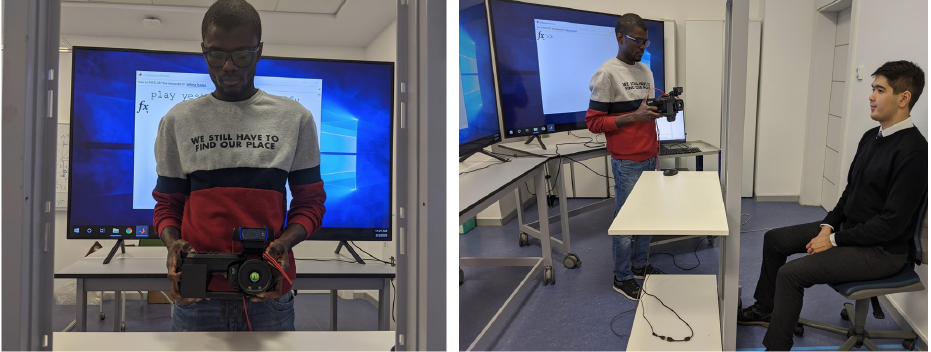
Figure 2. Data acquisition setup for